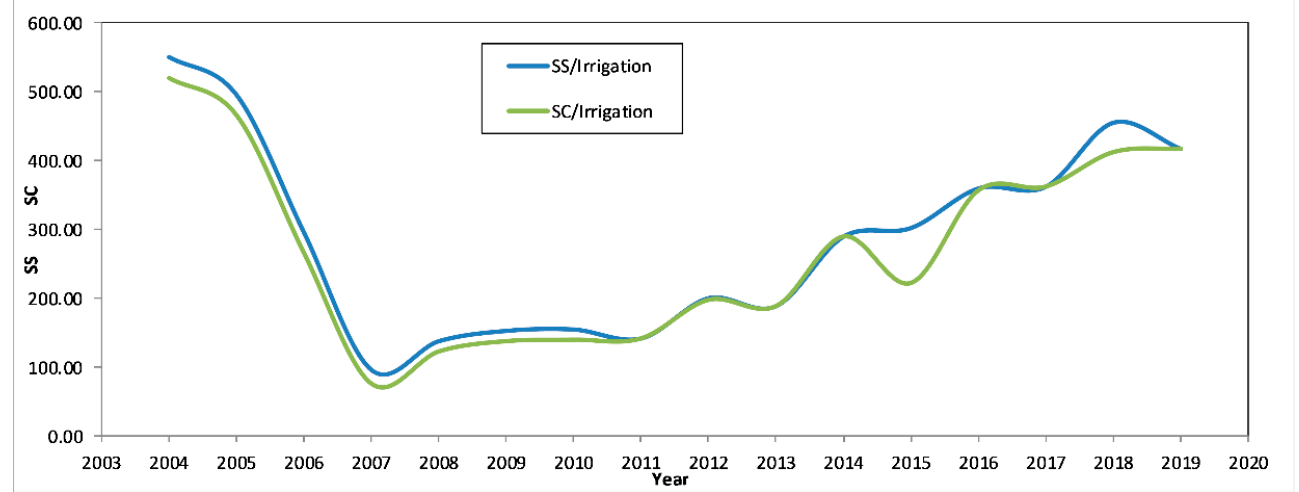
Figure 4. Sown and harvested area (in hectares) under irrigation in the studied area. Source: Authors’ elaboration based on statistical information from SIAP (2020).